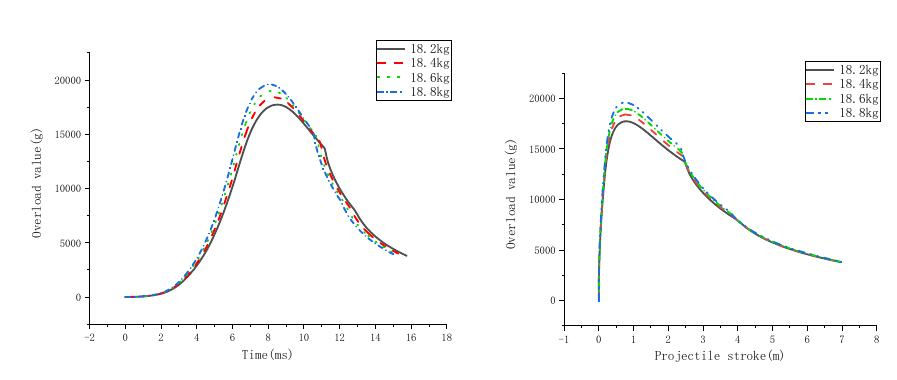
Fig. 3. a-l curves under different toyal charge mass.